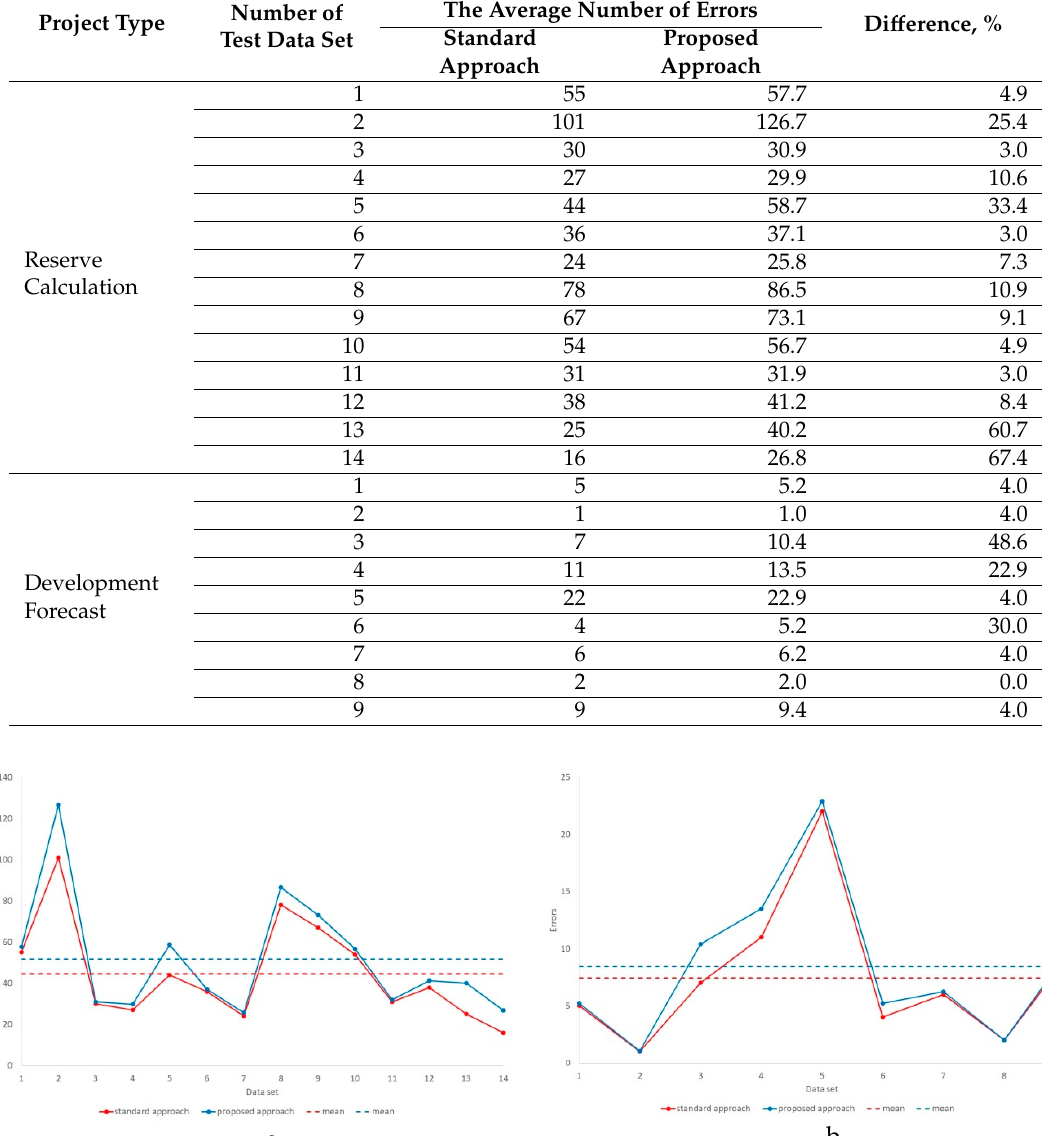
Table 4. The number of errors identified by experts during the initial data validation.